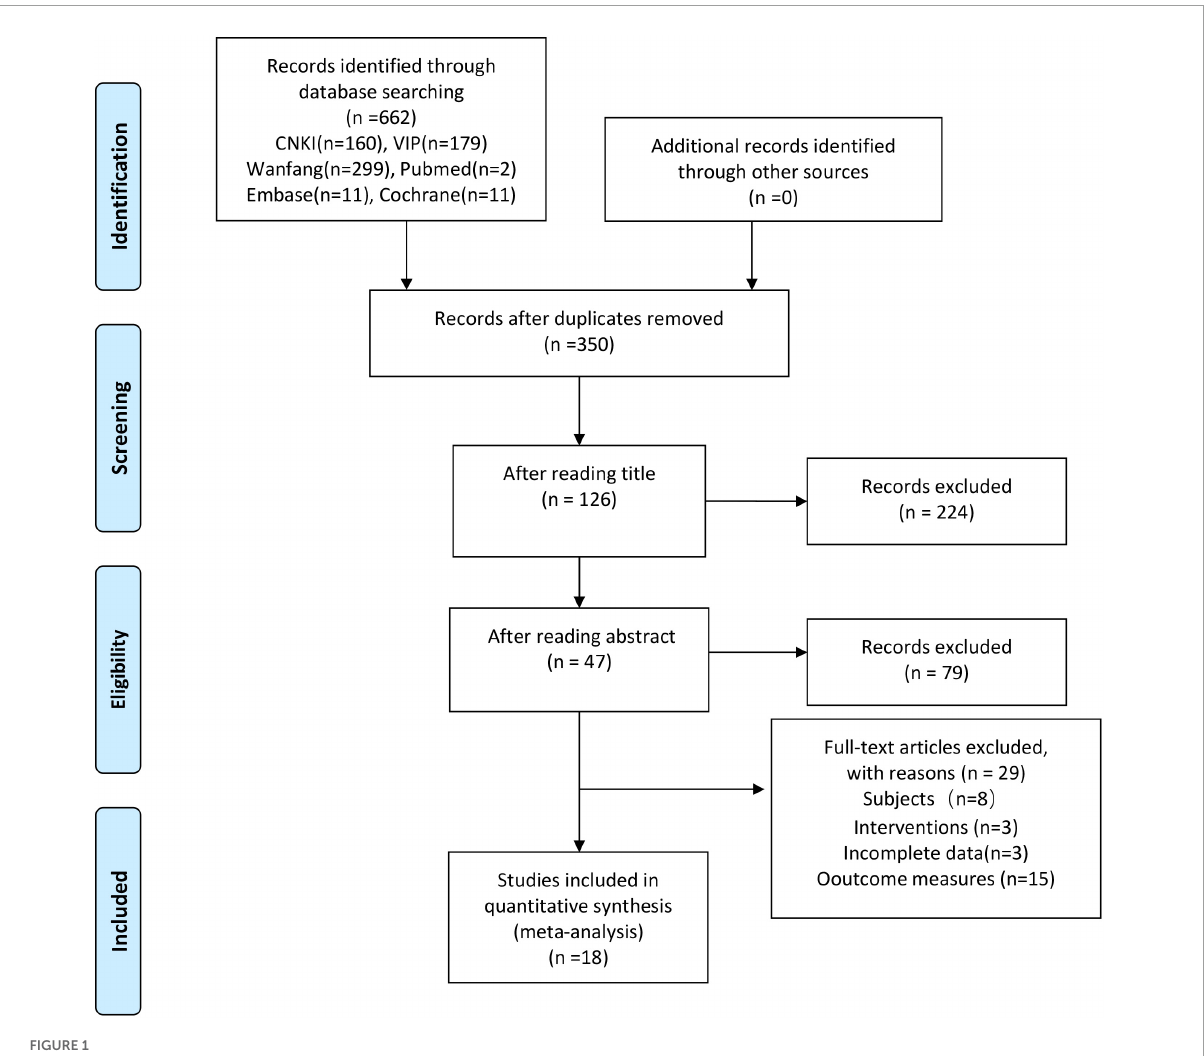
FIGURE1 Flow diagram of the study